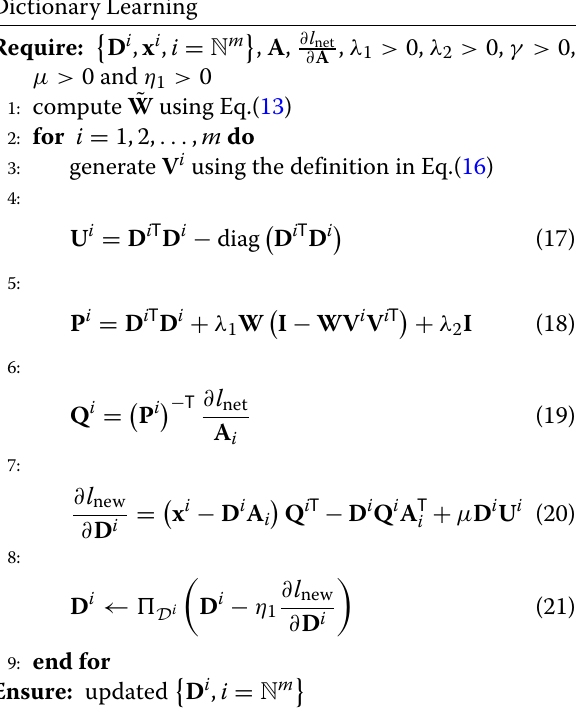
Algorithm 3 Backward Pass of Multimodal Sparse